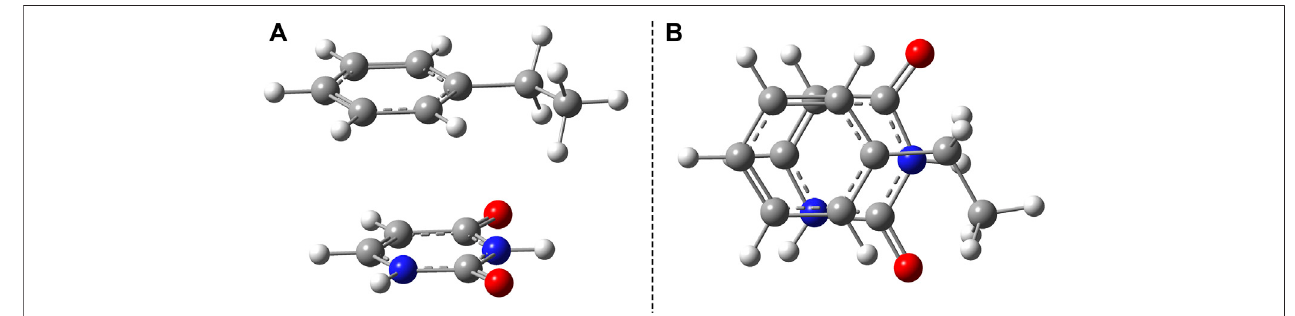
FIGURE 1 | Side (A) and top views (B) of the uracil – benzene dimer stacking con fi